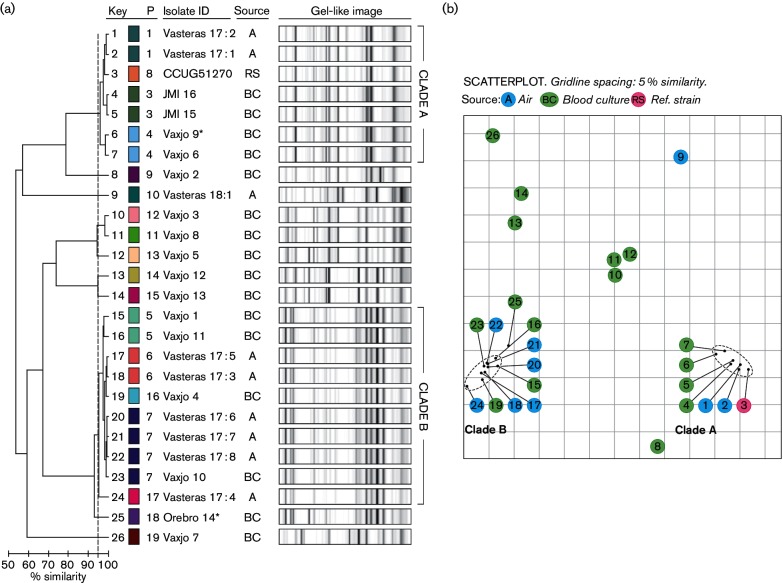
DiversiLab (DL) rep-PCR profiles of 26 S. pettenkoferi isolates. (a) Profiles and corresponding dendrogram obtained using the Kullback–Leibner method for correlation analysis. The similarity line (95 %) is presented as a light grey dotted vertical line. Each colour represents a single pattern (indistinguishable profiles). Isolates deemed clinically significant are marked with an asterisk. (b) Scatter plot of 26 S. pettenkoferi isolates. Each isolate is represented by its number corresponding to the DL profile, as presented in (a) ('key'). Colour represents origin of isolates [blue sampling (A); green, blood culture (BC); pinkreference strain (RS); pattern (P)].